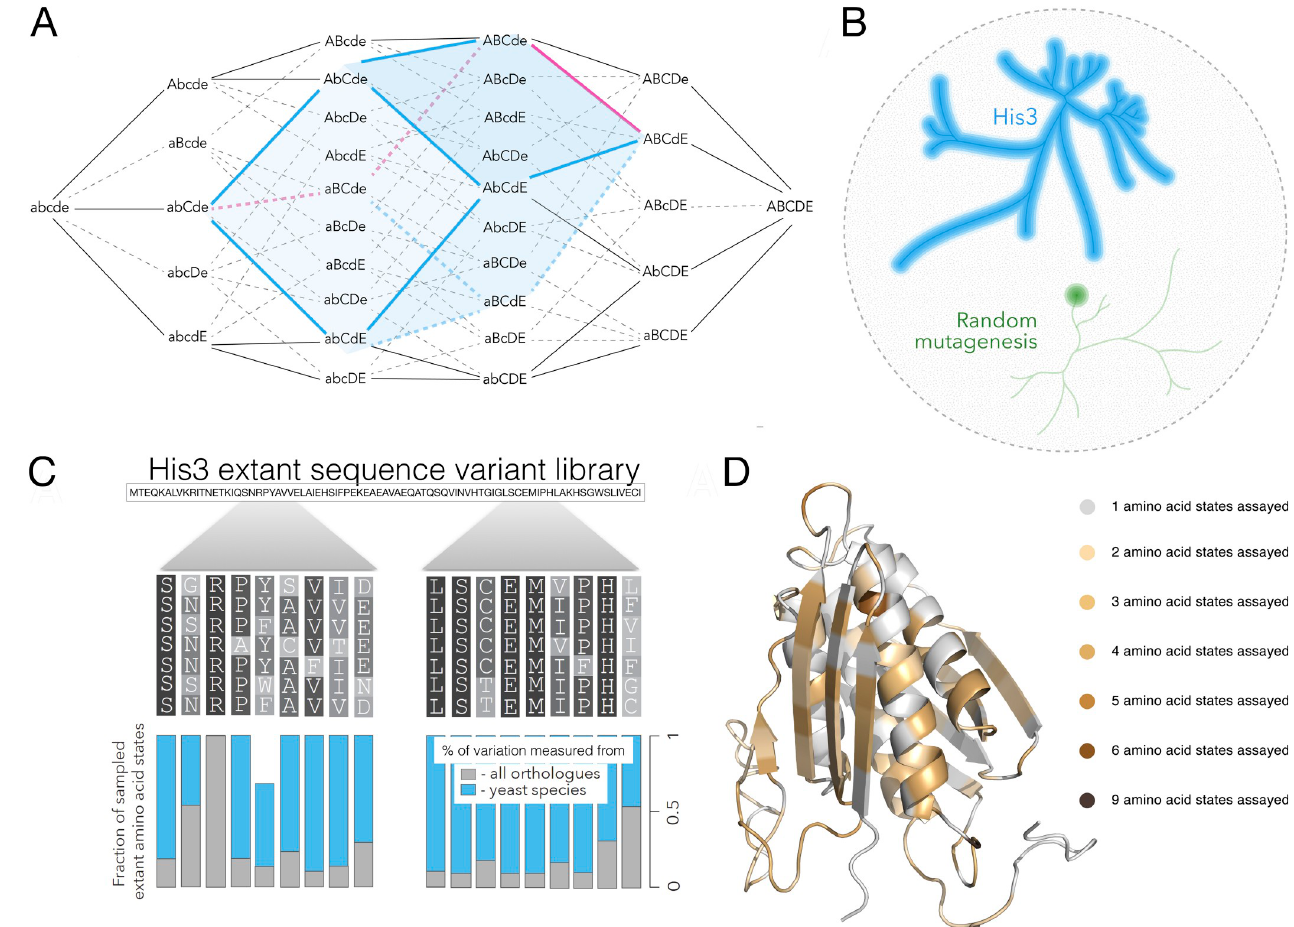
Fig 1. Combinatorial approach to the study of fitness landscapes. A fitness landscape is the representation of fitness for all possible genotypes composed of a specific set of loci. a, Following Fig 1 from Sewall Wright ref. [6] consider the genotype space consisting of 5 loci, each with two allele states (lower and uppercase letters). The entire genotype space is 5-dimensional consisting of 25 genotypes. Given two genotypes found in extant species (abCde and ABCdE in this example), surveying combinations of extant alleles substantially reduces the dimensionality of the genotype space, concomitantly reducing the number of genotypes to assay. The surveyed area (blue cube) considers all combinations of allele substitutions that have occurred in the course of evolution between the two sequences (red line), avoiding the sampling of combinations with less relevance to the evolutionary trajectory (black lines). b, Given the entire multidimensional genotype space (black circle) our approach considers a multidimensional subspace consisting of the combinatorial set of amino acid states from extant species. The blue line represents the yeast phylogeny and the surrounding blue space represents a multidimensional set of combinations of extant amino acids of the sequence under consideration, one His3 gene segment in our study. By contrast, random mutagenesis studies consider only a local segment of the genotype space surrounding a specific genotype (green circle). , A multiple alignment of orthologous sequences of His3 for segment 2 for which we incorporated almost all extant amino acid states from 21 yeast species (blue bars) and 10-100% extant states from a set of 396 orthologues (grey bars). d, The predicted structure of His3p with amino acid residues that were substituted in our library.